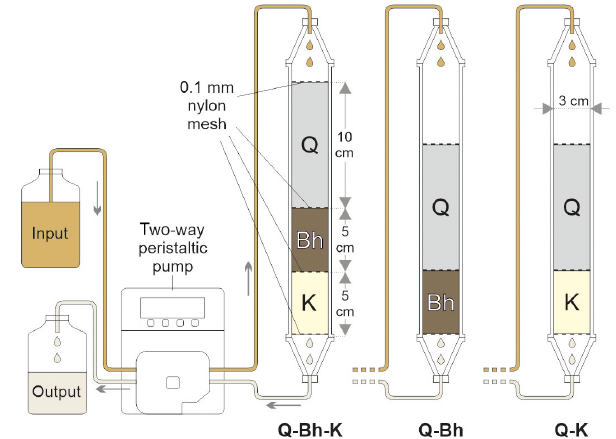
Figure 2. Concentration of the DOC in the five fractions (F1 to F5) of the column percolate and in the composite sample. Analytical errors are smaller than the point